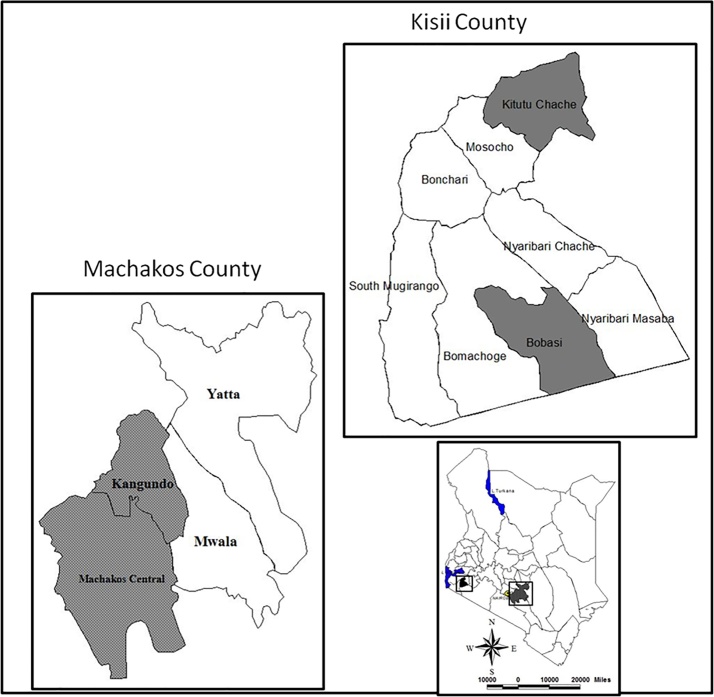
Map of Study areas.